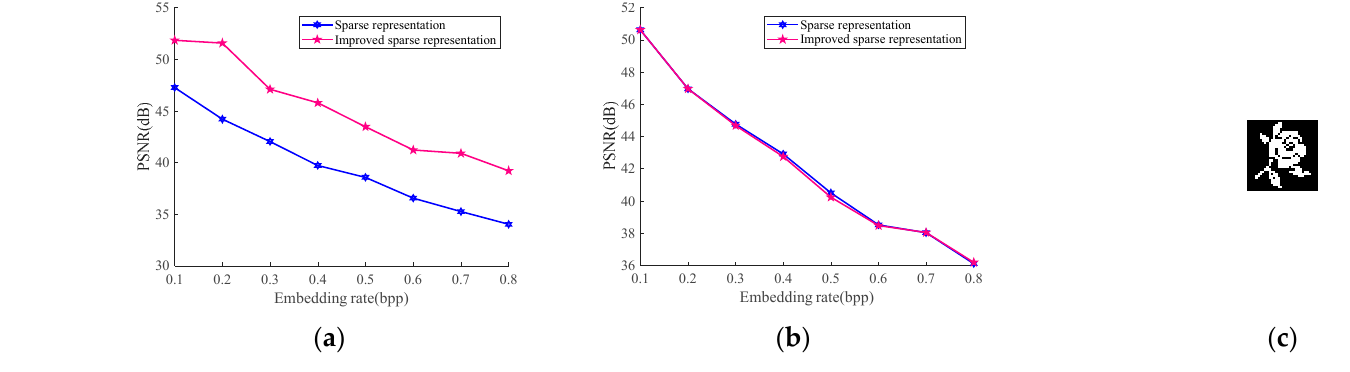
Figure 10. Comparisons between the sparse coding in [13] and the improved sparse coding: ( a ) secret data is in image form; ( b ) secret data is generated randomly; and ( c ) flower.